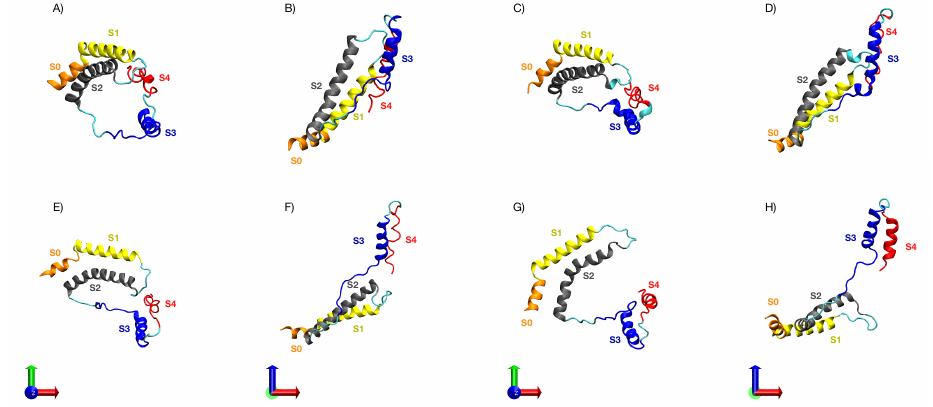
Figure 11. Cartoon representations of representative VSD conformations for each cluster from different perspectives. ( A ) Representative VSD of cluster 1, top view. ( B ) Representative VSD of cluster 1, side view. ( C ) Representative VSD of cluster 2, top view. ( D ) Representative VSD of cluster 2, side view. ( E ) Representative VSD of cluster 3, top view. ( F ) Representative VSD of cluster 3, side view. ( G ) Representative VSD of cluster 4, top view. ( H ) Representative VSD of cluster 4, side view. The S0 helix is highlighted in orange, the S1 helix is highlighted in blue, the S2 helix is highlighted in gray, the S3 helix is highlighted in yellow and S4 is highlighted in red.